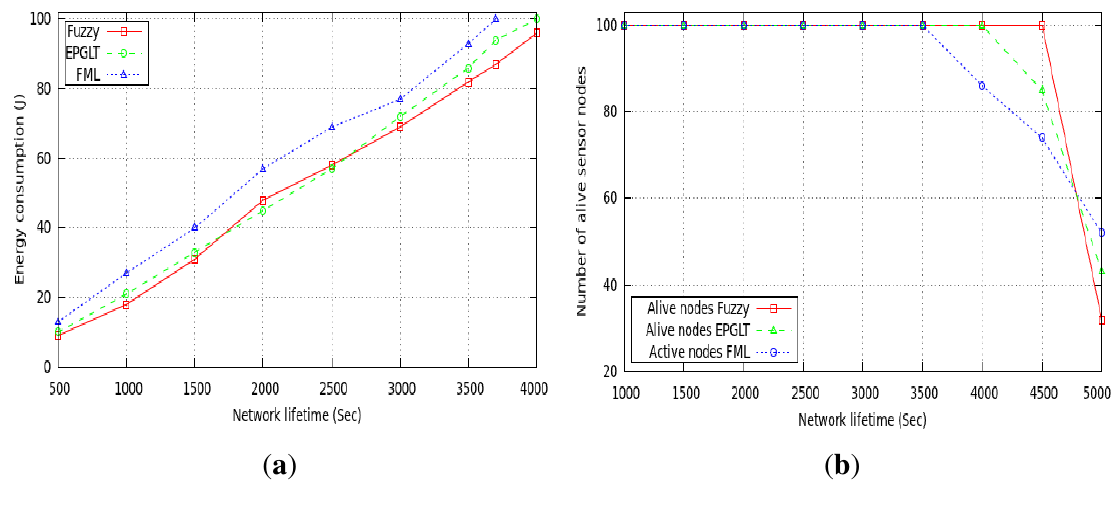
Figure 6. Network lifetime. ( a ) Guaranteed lifetime; ( b ) working and live nodes in each round.